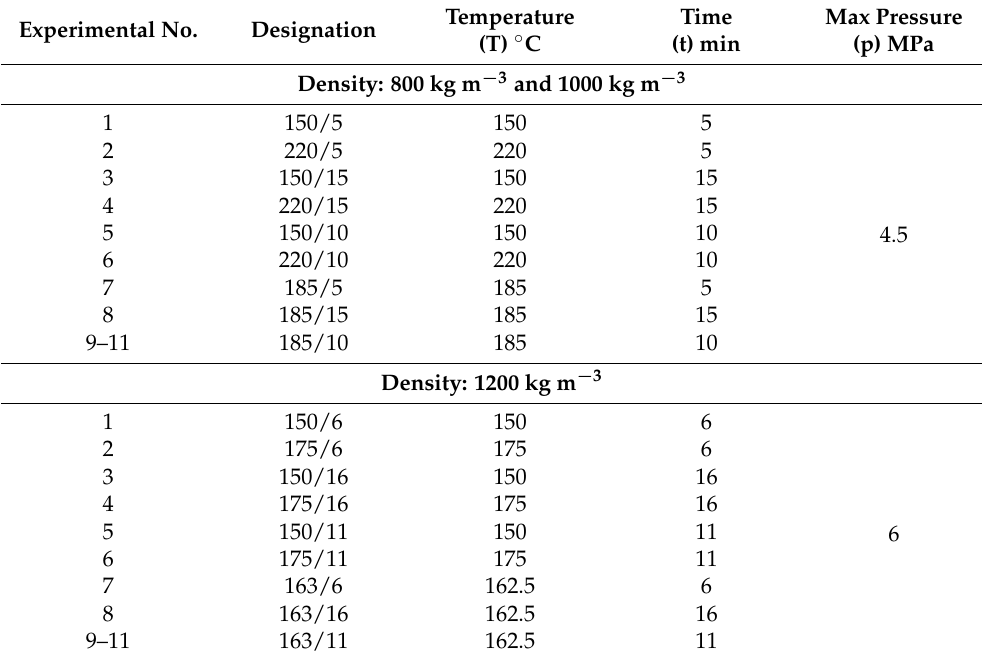
Table 1. Experimental design for the binder-less board pressing cycle. Experimental